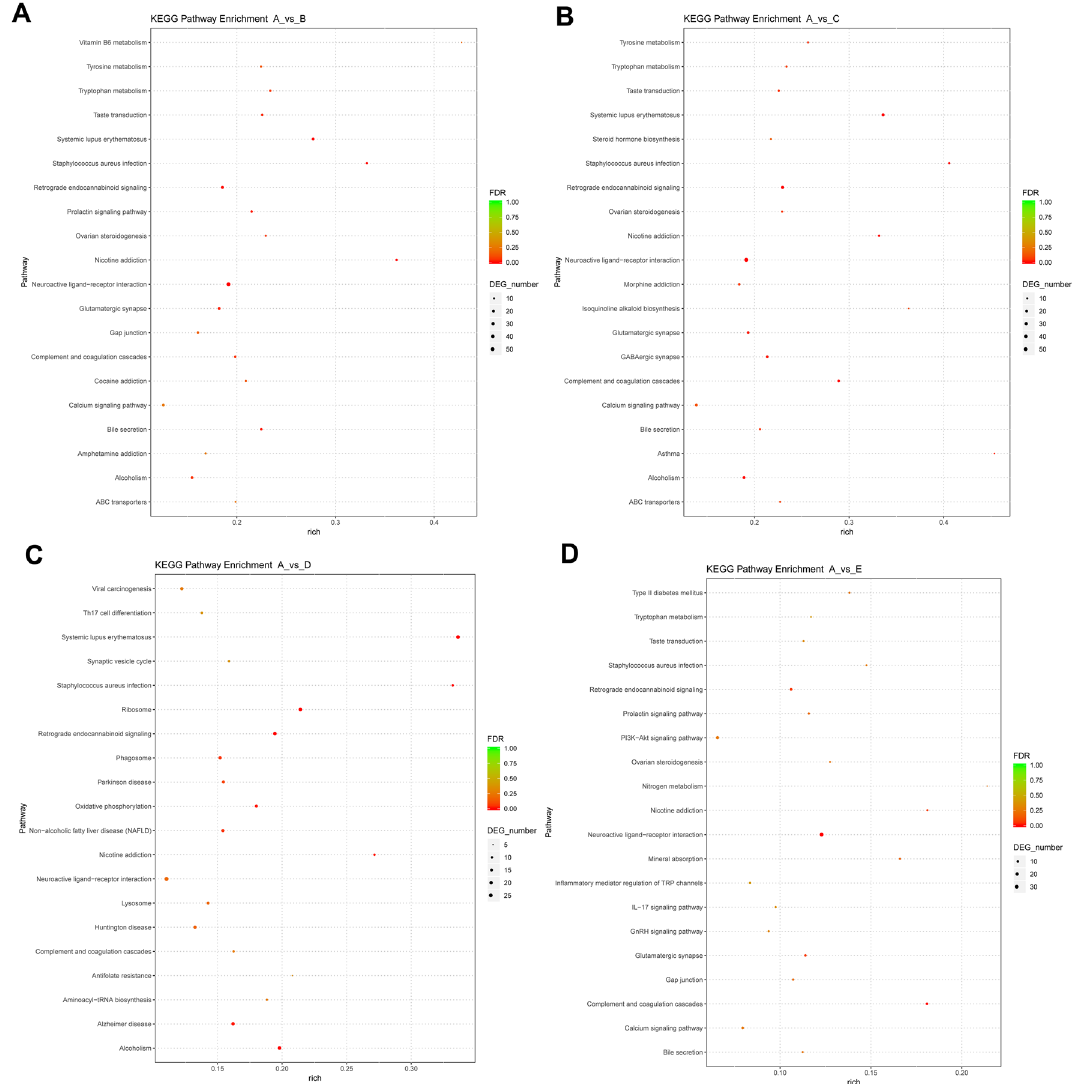
Figure 4. KEGG enrichment analysis for DE genes. ( A – D ) Top 20 KEGG pathways enriched by DE genes in B vs A, C vs A, D vs A, and E vs A groups, respectively. Pathway in the Y-axis represents the KEGG pathway term enriched by differentially expressed genes. The “rich” in the X-axis represents the rich factor. Rich factor: the number of differentially expressed genes in the pathway term/the number of all annotated genes in the pathway term. FDR: P value after the correction of False Discovery Rate (FDR). DEG_number: number of differentially expressed genes in the KEGG pathway term. KEGG enrichment analysis was performed as previously described 48–50